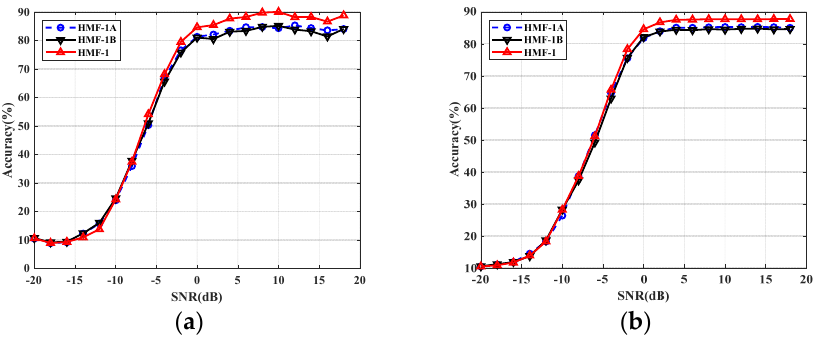
Figure 5. Classification accuracy performance comparison of the proposed HMF-I with its subnetworks on ( a ) RadioML2016.10a and ( b ) RadioML2016.10b.